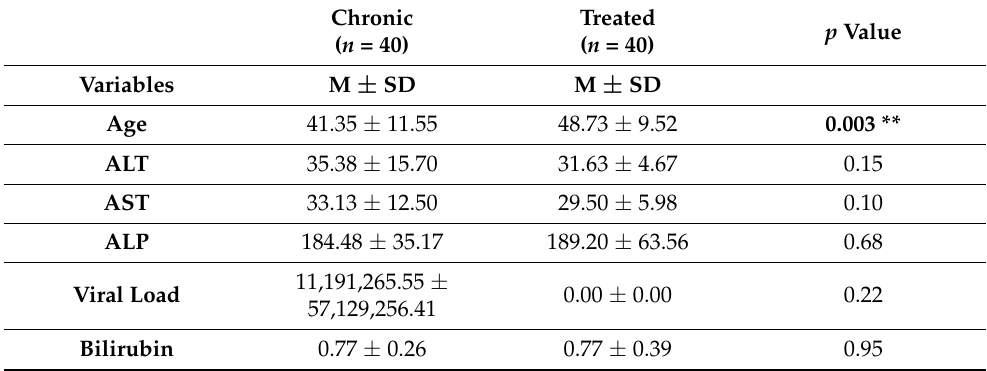
Table 5. Association of age and biochemical parameters considering the chronic and treated